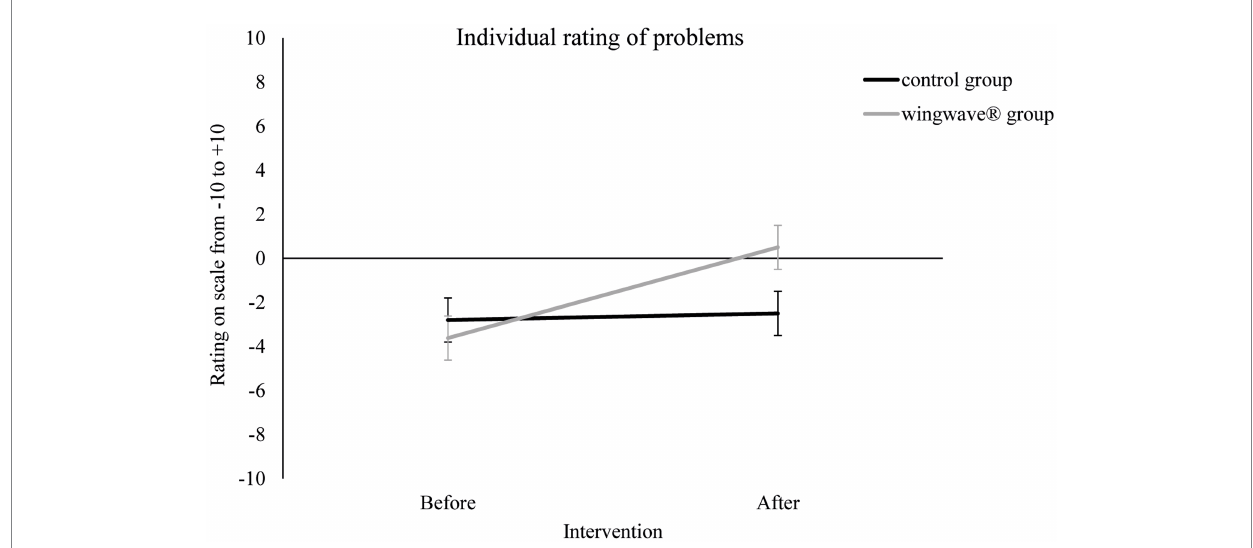
FIGURE 2 Individual ratings of team sport related problems as a function of treatment group (wingwave ® , control) and moment of testing relative to intervention (before, after). Error bars indicate SEs.